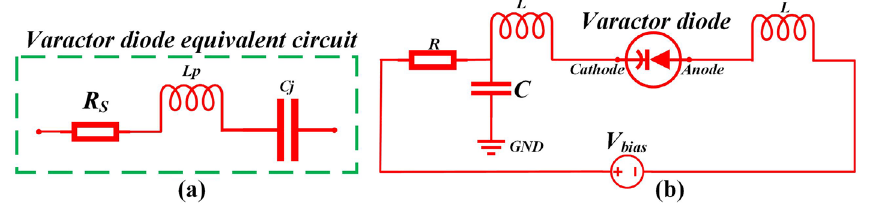
Figure 4. ( a ) The simple equivalent circuit of varactor diode (Skyworks SMV 1405-079LF), ( b ) The DC bias circuit for varactor